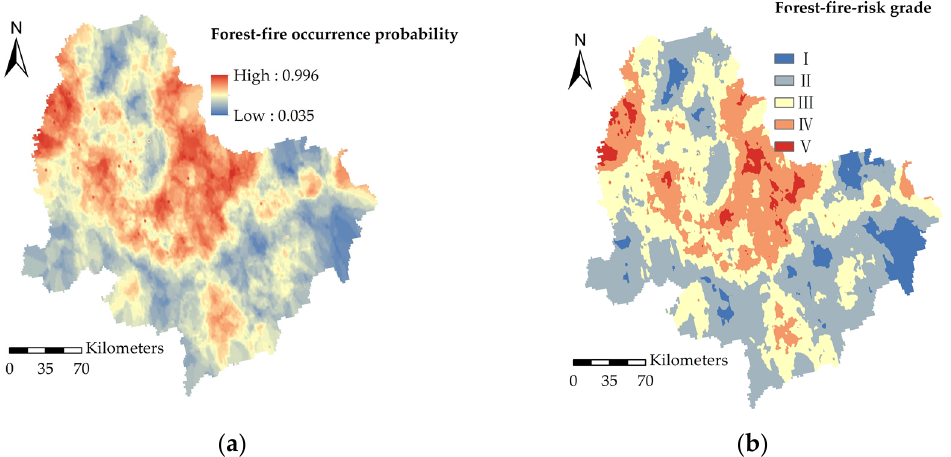
Figure 7. Forest-fire occurrence probability and risk distribution based on RF algorithm. ( a ) Forest-fire occurrence probability. ( b ) Forest-fire-risk distribution.